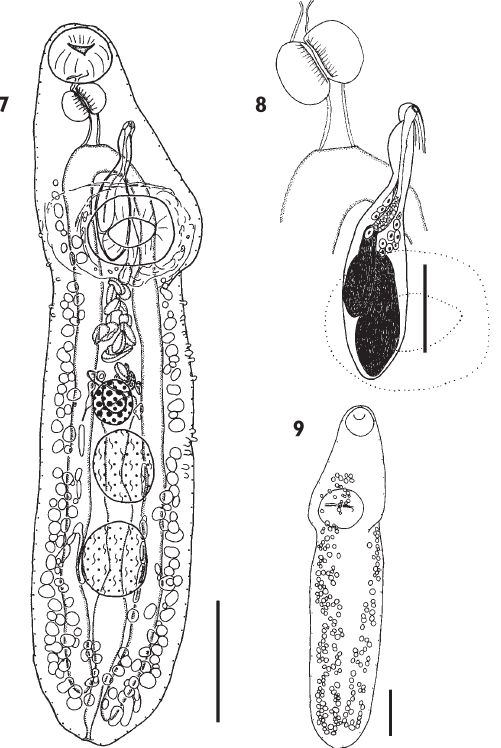
Figs 7-9. Macvicaria mekistomorphe n. sp. ex Sillago maculata . 7. Whole-mount ventral view. 8. Terminal genitalia. 9. Dorsal distribution of vitelline follicles. Scale bars : 7, 9, 250 μm; 8, 100